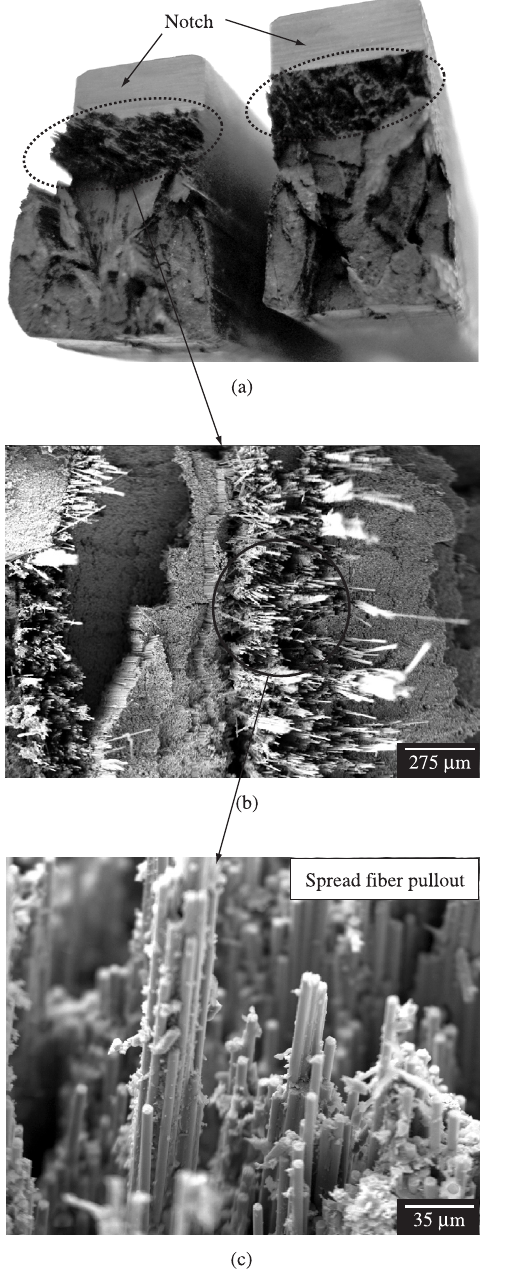
Figure 9. Fracture surface profile of impacted TP180 laminate tested at 100 °C: a) Macroscopic view; b) SEM view; and c) SEM magnification of (b).